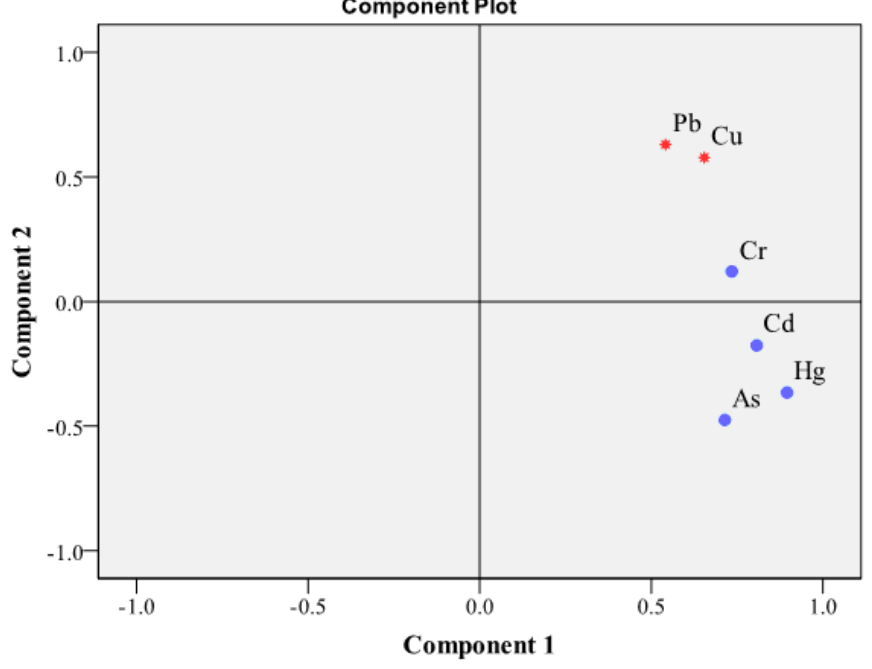
Figure 3. Principal component analysis of the heavy metal concentrations in soils from the study area.